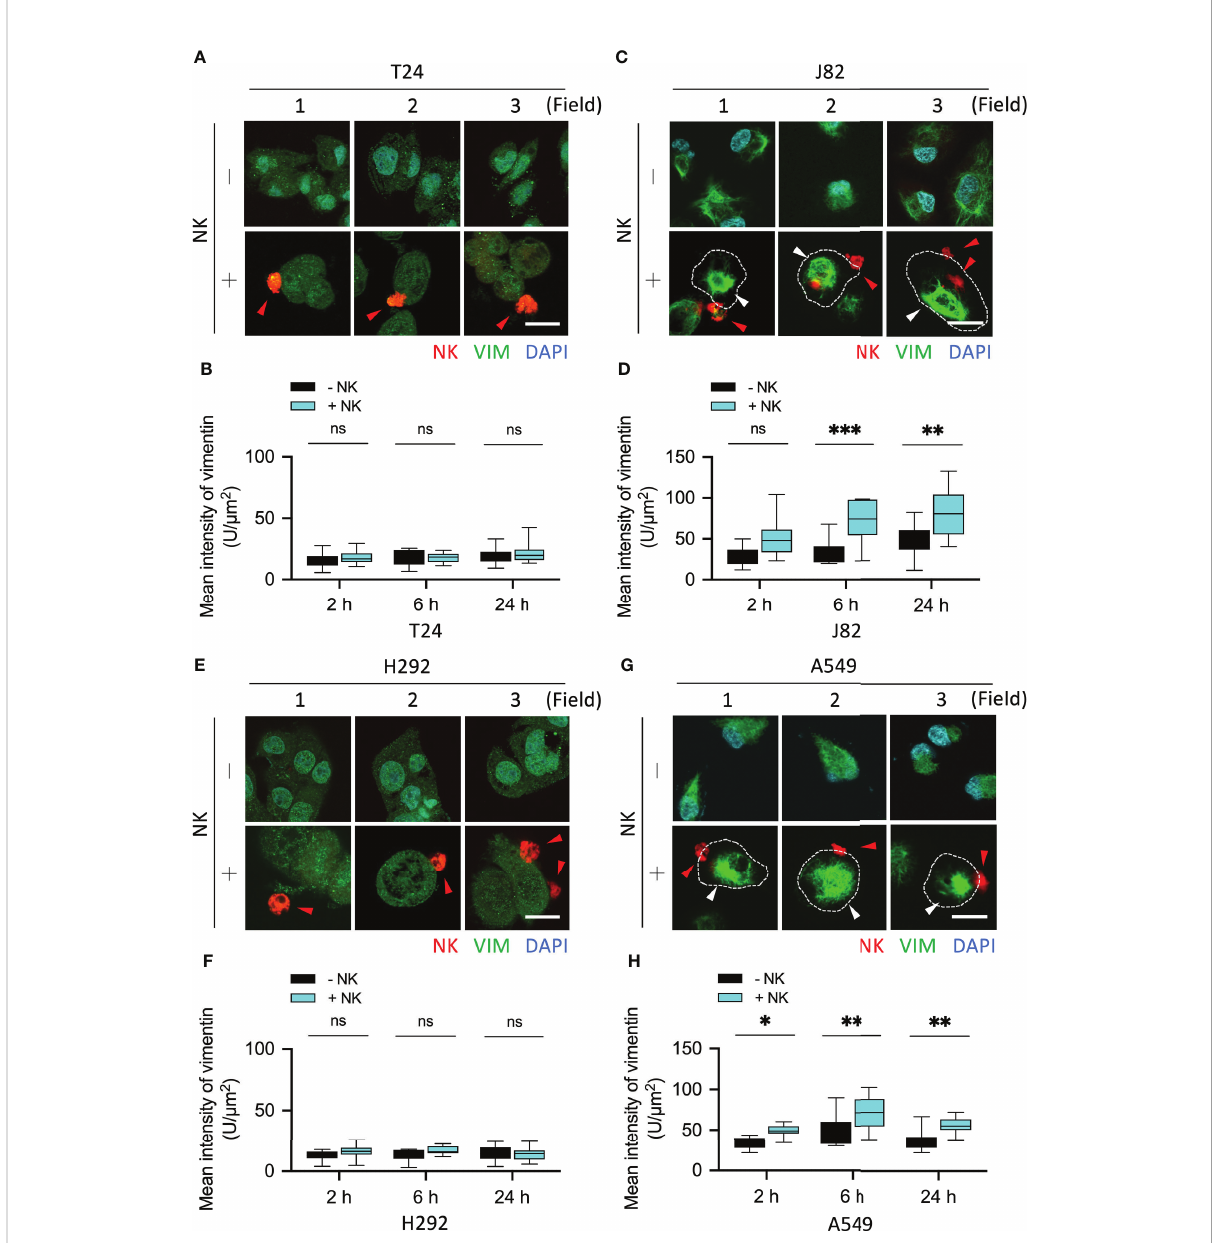
FIGURE 5 NK cells induced vimentin expression in the immune-resistant cancer cells. (A, C) Comparison of the expression of vimentin in NK cell-interacted cancer cells. T24 and J82 cells were incubated with NK cells for 2, 6 and 24 h, and the expression of vimentin was detected using immuno fl uorescence assays. (B, D) The intensity of vimentin was measured and quanti fi ed by ImageJ. (E, G) H292 and A549 cells were incubated with NK cells for 2, 6 and 24 h, followed by the detection of vimentin expression. (F, H) Quanti fi cation of the intensity of vimentin using ImageJ. ns, not signi fi cant; *P < 0.05; **P < 0.01; ***P < 0.001. Data are presented as mean ± s.d. (two-way ANOVA with Sidak's multiple comparisons test). Red arrowhead, NK cell; white arrowhead, vimentin. Scale bars, 20 µm. Data derived from 10 fi elds, each including 2 – 3